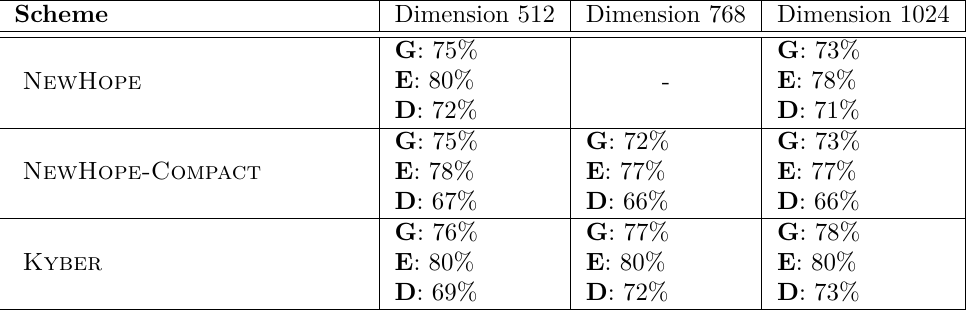
Table 5: Time spent hashing. G : key generation, E : encapsulation, D : decapsulation.